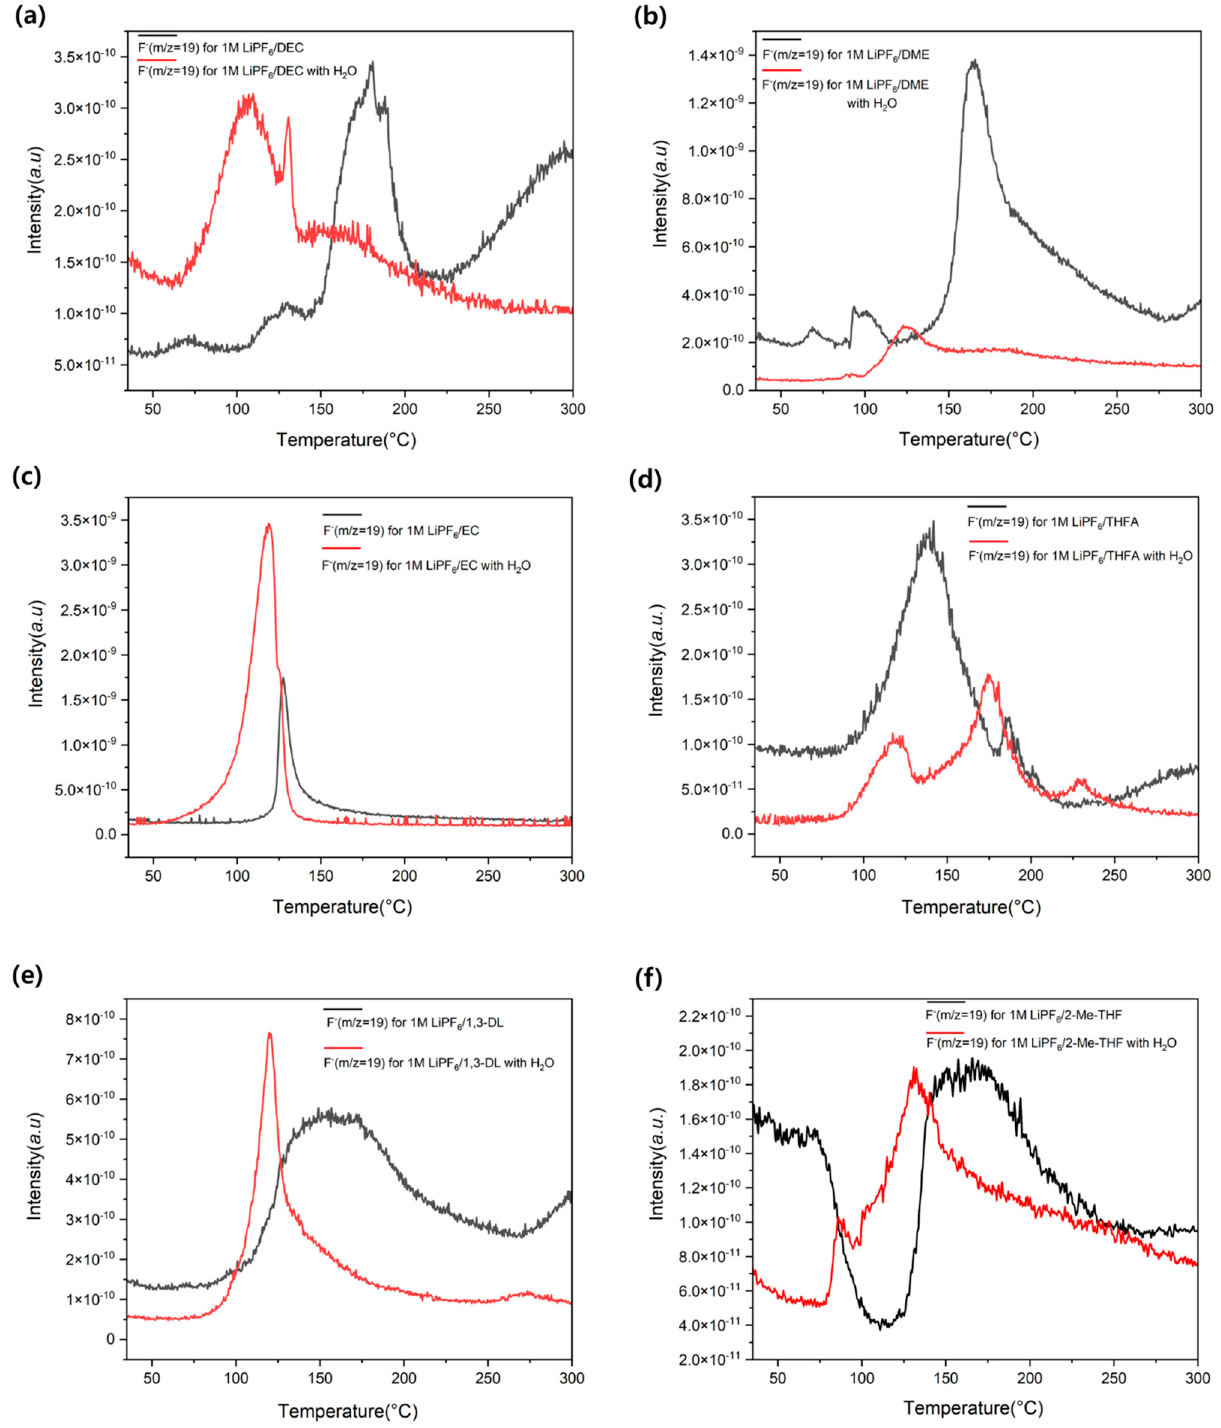
Figure 4. Mass spectral peaks of F − and generation temperature for each 1 M electrolyte solution containing LiPF 6 with added water (red) and without water (black). F − mass spectral peaks for ( a ) 1 M LiPF 6 /DEC, ( b ) 1 M LiPF 6 /DME, ( c ) 1 M LiPF 6 /EC, ( d ) 1 M LiPF 6 /THFA, ( e ) 1 M LiPF 6 /1,3-DL, and ( f ) 1 M LiPF 6 /2 ‐ Me ‐ THF.